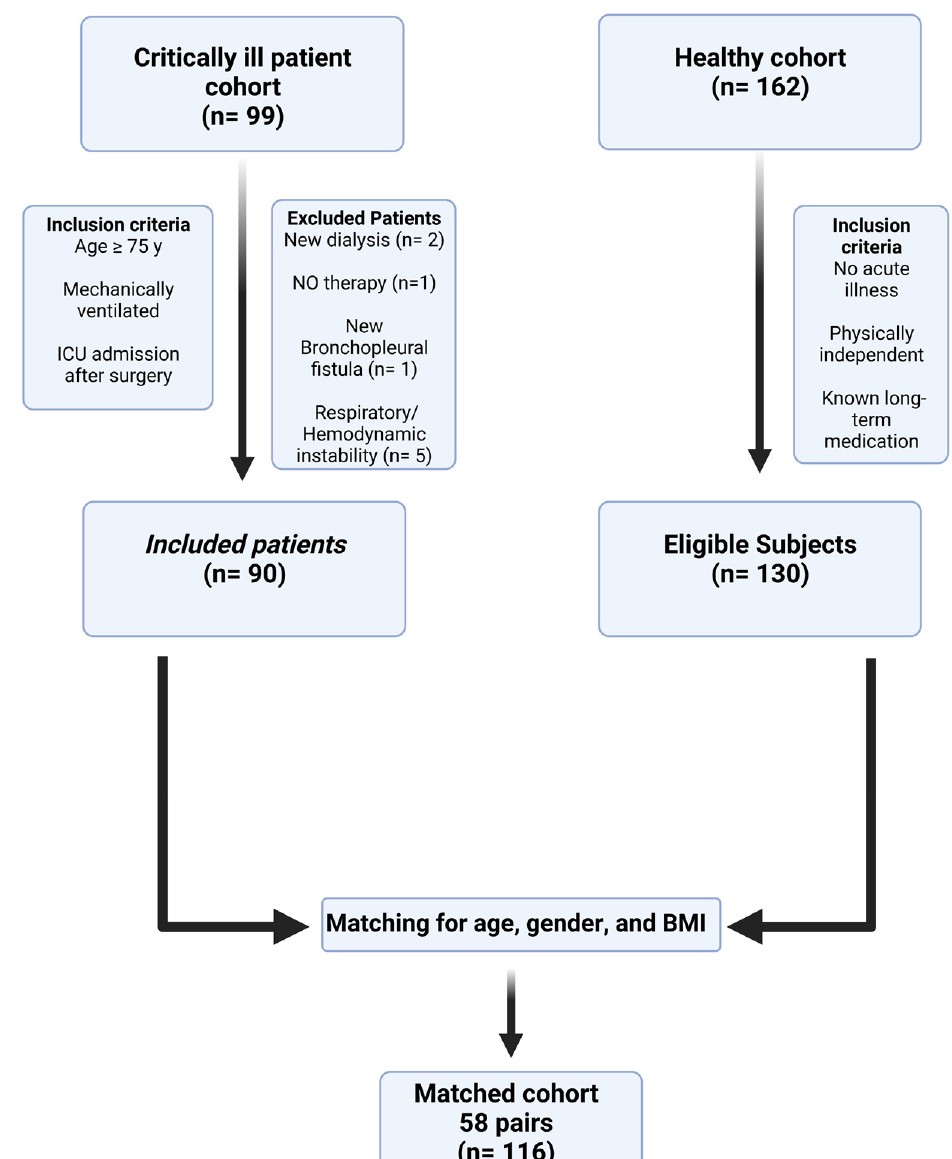
Figure 1. Study flow chart illustrating inclusion and matching process. The critically ill patient cohort comprised of N = 90 patients. For the matched cohort, N = 58 critically ill patients were matched by age, gender and BMI with subjects from the healthy cohort. Abbreviations. ICU: intensive care unit, NO: nitric oxide, BMI: body mass index. Table 1. Baseline characteristics and physiologic data of the critically ill patients cohort (N = 90) and matched cohort (with values given for N = 58 healthy controls and N = 58 critically ill patients). All values are expressed as medians with 25% and 75% percentiles. Abbreviations. ACS: acute coronary